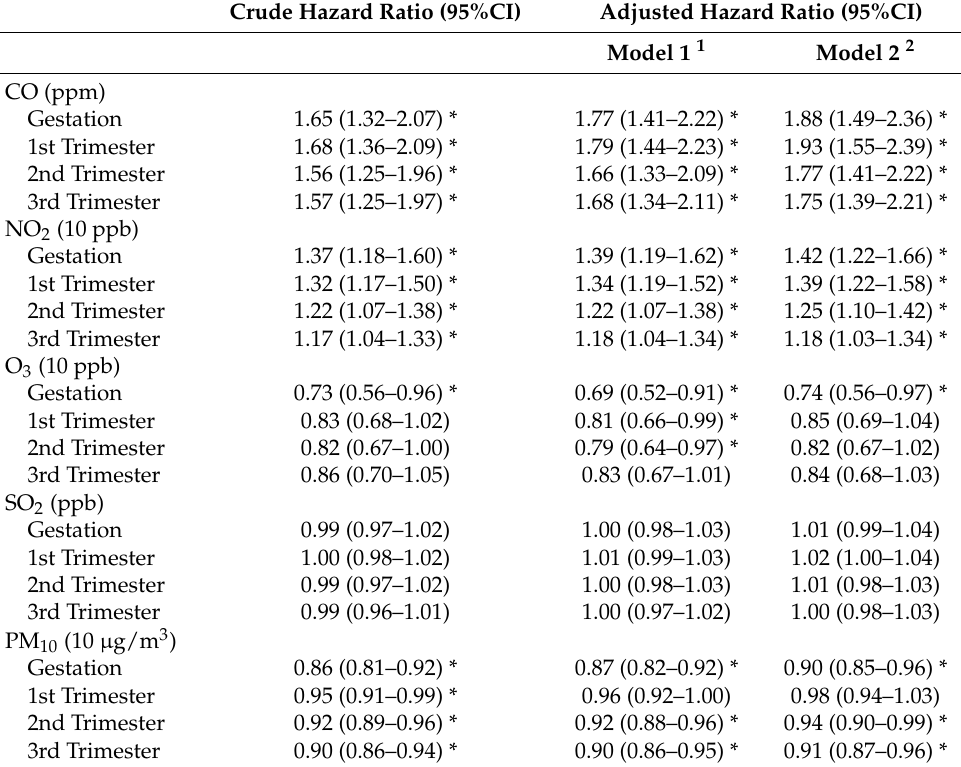
Table 3. Crude and adjusted hazard ratios for autism spectrum disorder associated with air